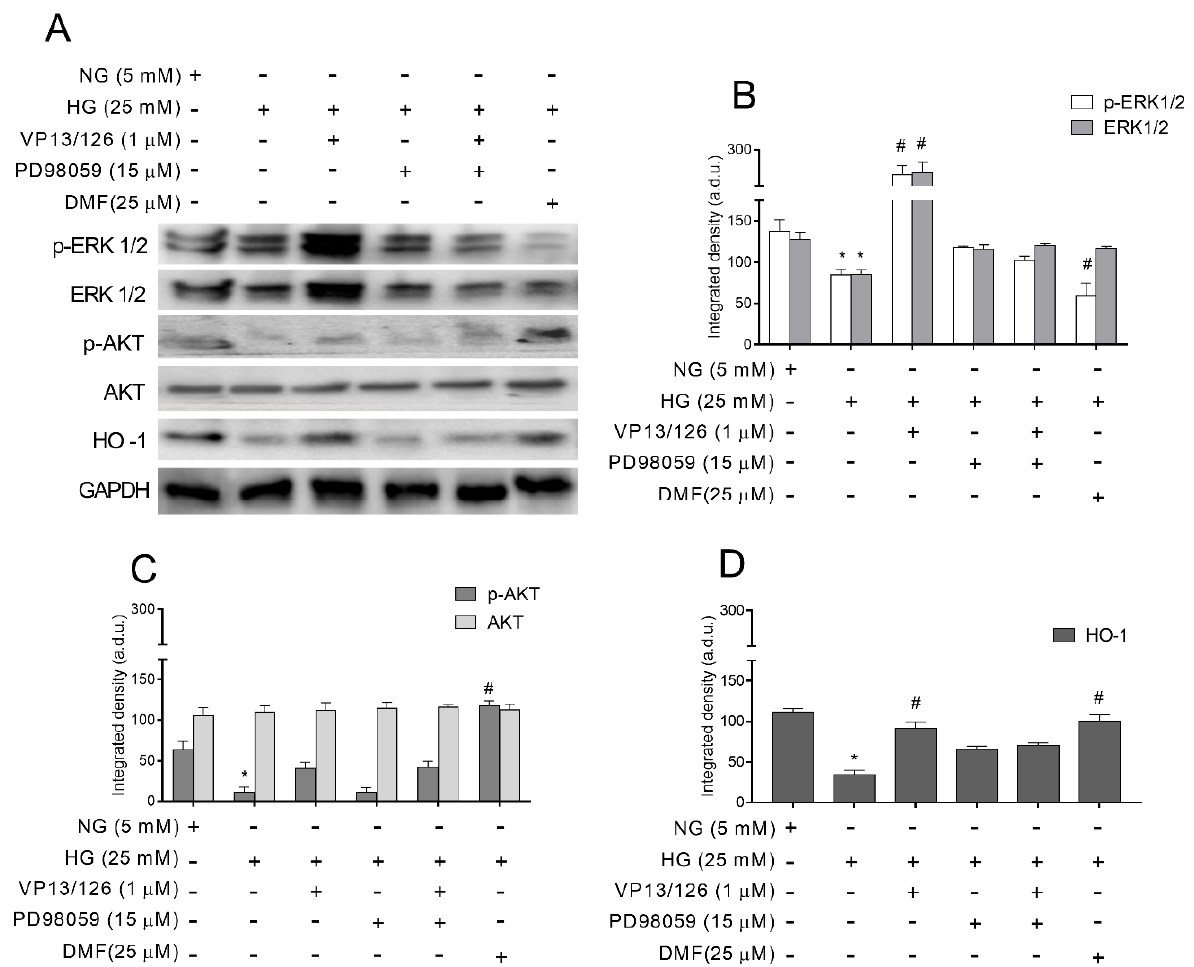
Figure 5. Effects of VP13/126 on phospho-ERK 1/2, total ERK1/2, phospho-AKT, total AKT and HO-1 protein expression in SIRC stimulated by high glucose. Proteins were analyzed by Western blot analysis in SIRC cultured in normal glucose (5 mM) or treated with HG (25 mM) alone or in presence of VP13/126 (5 µ M), of PD98059 (15 µ M), VP13/126 (5 µ M) plus PD98059 (15 µ M) or with 25 µ M of DMF for 48 h. ( A ) shows representative images of immunoblot for phospho-ERK1/2 (p-ERK1/2), total ERK1/2 (ERK1/2), phospho-AKT (p-AKT), total AKT (AKT), heme oxygenase-1 (HO-1) and GAPDH proteins. GAPDH detection indicates the equal loading of 40 µ g of protein in each lane. Immunoblot quantification regarding phospho- and total ERK1/2 ( B ), phospho- and total AKT ( C ) and HO-1 ( D ) protein levels were performed by densitometric analysis of each band (in arbitrary densitometry units, a.d.u.), through the Image J software. All data represent mean ± SEM obtained from at least three independent experiments. * p < 0.05 vs. Ctrl; # p < 0.05 vs. HG alone in the respective conditions. Two-way ANOVA, followed by Tukey’s test.